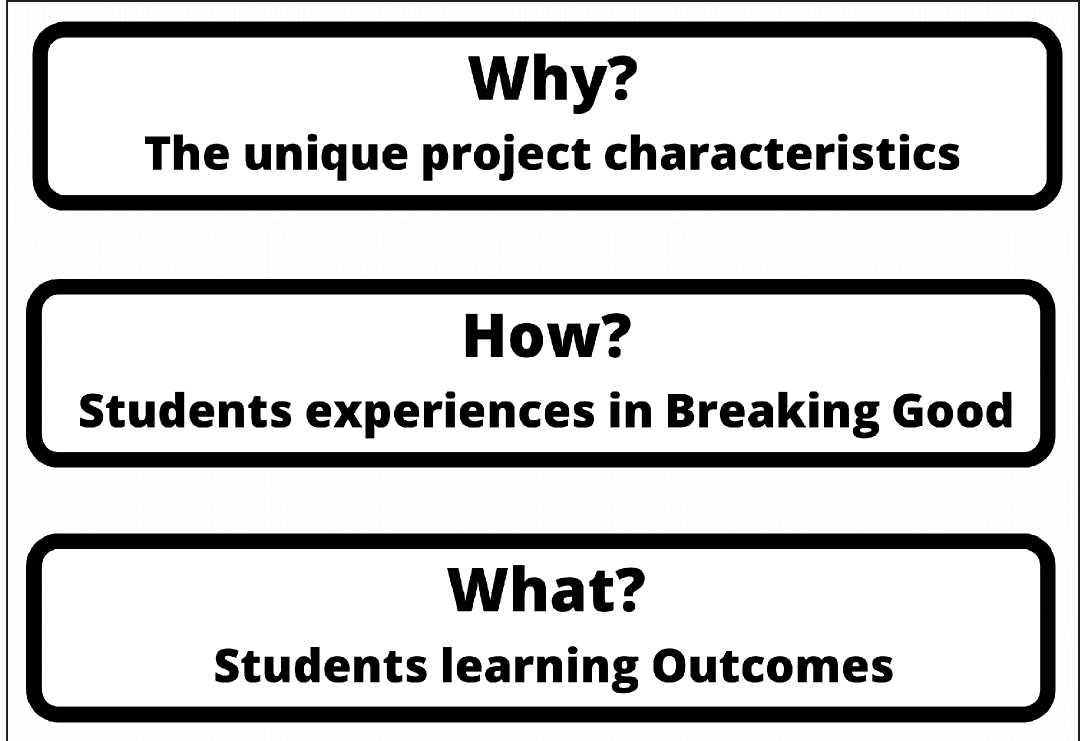
Figure 2 Outline of students learning processes and